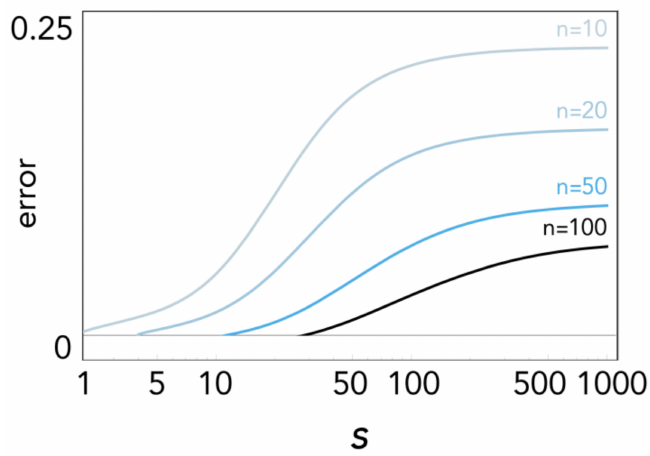
Figure 6. Error [ ∆ b − β ∗ ( x ) ] at the stable equilibrium, as a function of s , for different values of n ; c = 0.01, h =